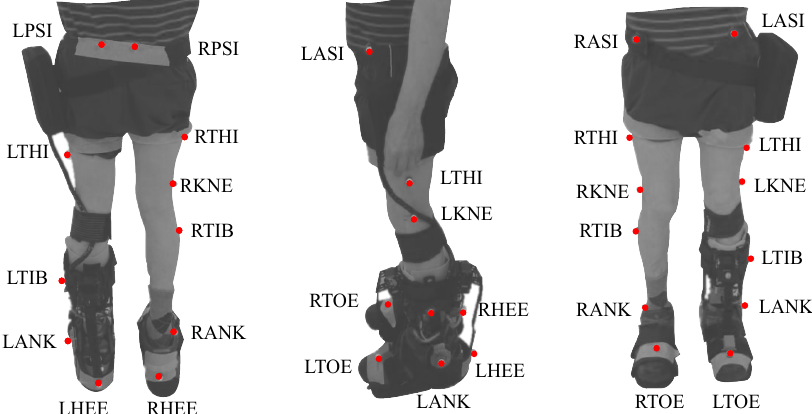
Figure 3. Biomechanical setup model used in the study for each participant based on the plug-in gait marker model. The red points on the patient represent the markers and the biological landmarks for the VICON acquisition system. This model involves markers in the Right and Left Posterior Iliac Spines (RPSI and LPSI), Right and Left Anterior Superior Iliac Spines (LASI and RASI), Right and Left Thighs (RTHI and LTHI), Right and Left Knees (RKNE and LKNE), Right and Left Tibias (RTIB and LTIB), Right and Left Ankles (RANK and LANK), Right and Left Toes (RTOE and LTOE), and Right and Left Heels (RHEE and